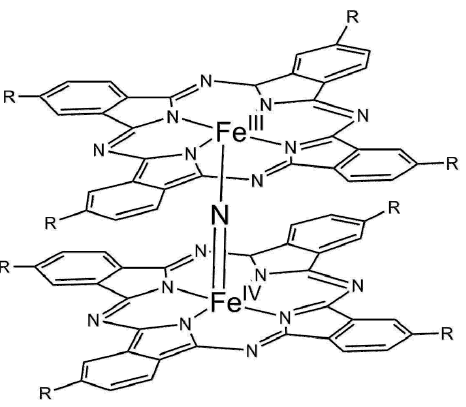
Figure 3. The μ‐ ntirido diiron phthalocyanine complex used by Sorokin and co ‐ workers. Figure 3. The µ -ntirido diiron phthalocyanine complex used by Sorokin and